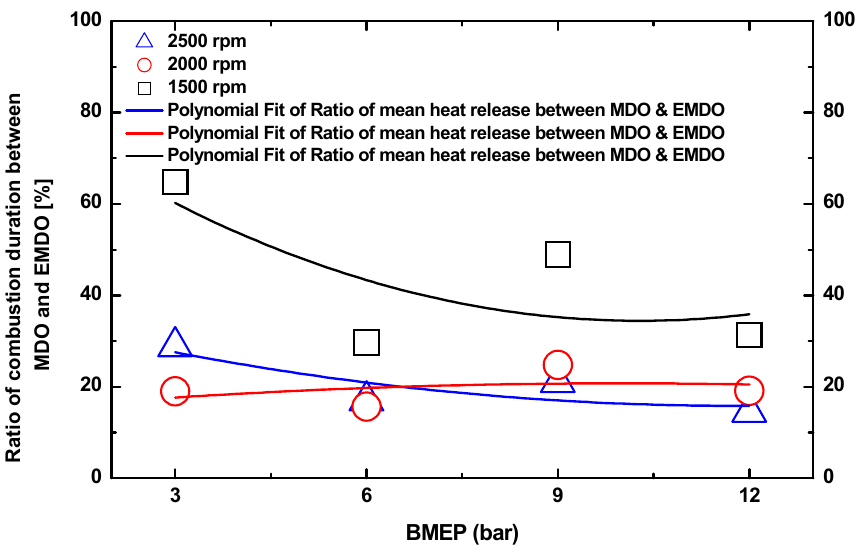
Figure 8. Ratio of mean heat release between marine diesel oil (MDO) and emulsified MDO (EMDO) according to rpm.